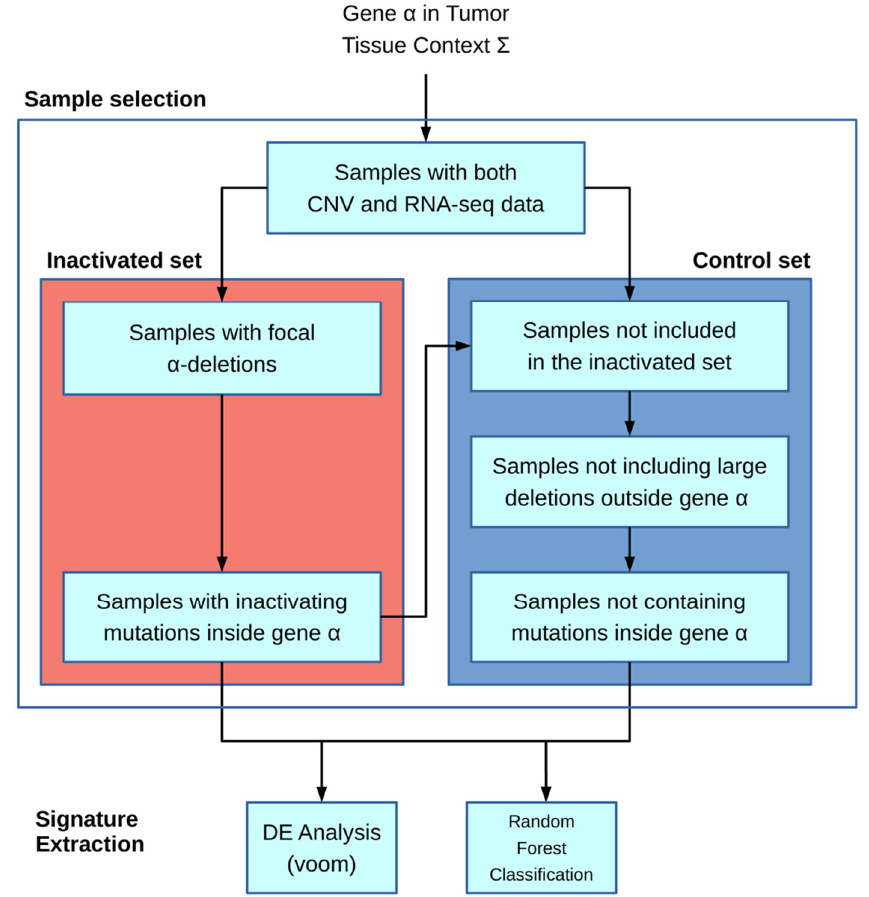
Figure 1. A schematic representation of the ICAro (gene signature Inference system from Copy number Aberrations) workflow. The first part relies on sample filtering based on deletions and inactivating mutations spanning the gene target α in order to build the inactivated and the control sample sets. They are used as input for the signature extraction process, performed via a differential gene expression analysis (the voom function from limma) and a Random Forest classification (randomForest R package).